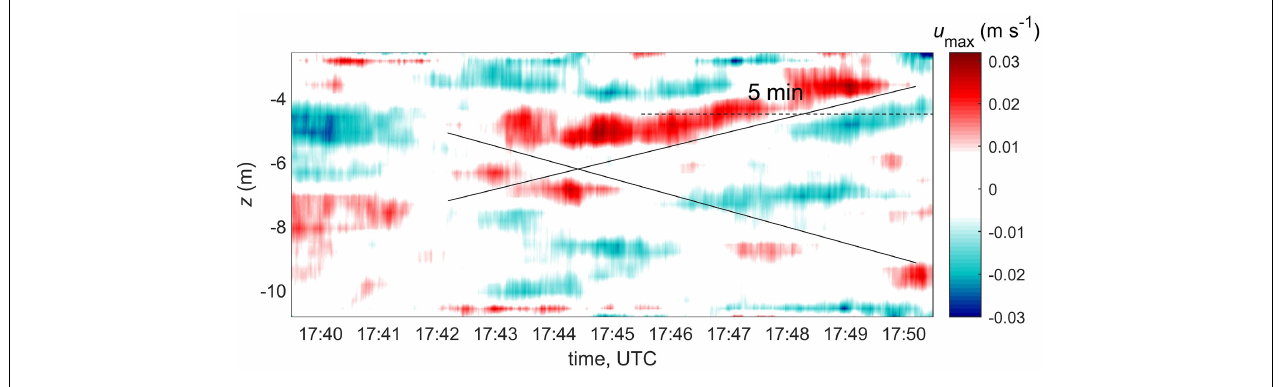
FIGURE 14 | Band-passed maximum velocity component from ADCP data at station 12. Black lines show approximate direction of the internal wave phase propagation; dashed line indicates the internal wave